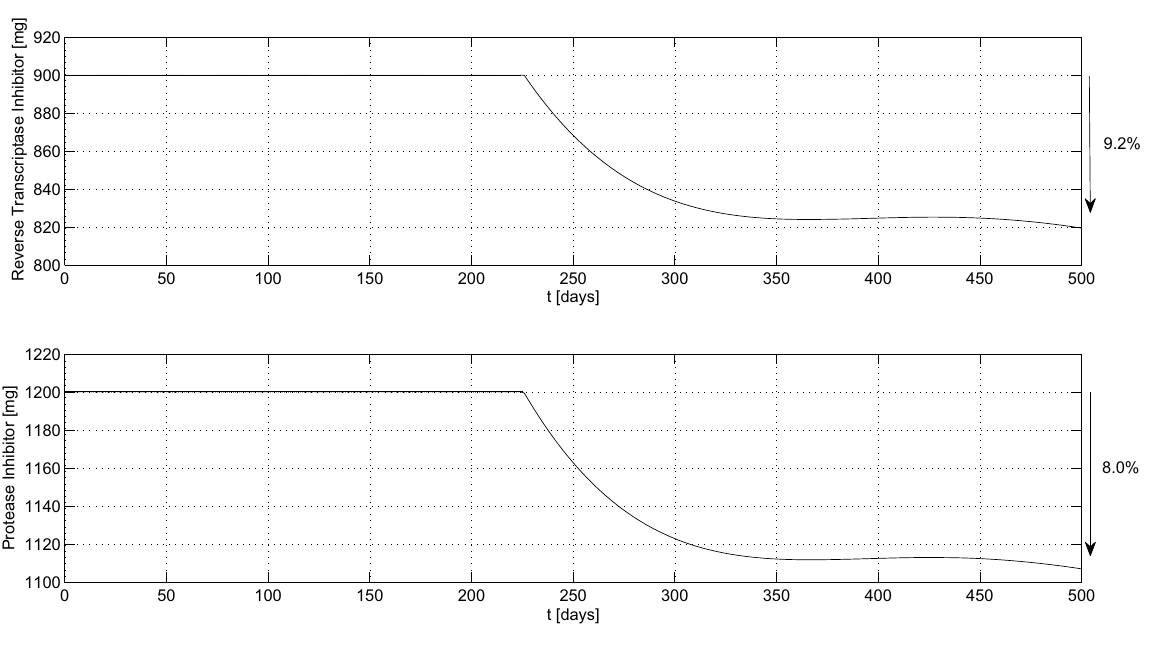
Fig. 3 – Drug doses. Reverse transcriptase inhibitor decrease about 9.2% and protease inhibitor about 8% after the star of LQR